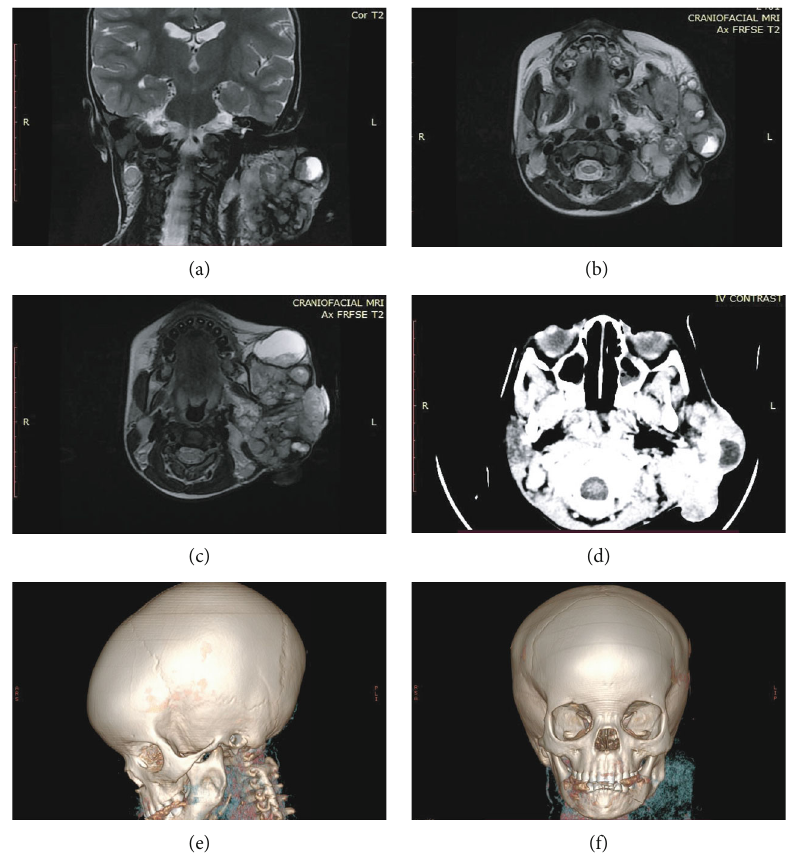
Figure 2: Radiologic imaging of a female child diagnosed with a MAML2 -rearranged mucoepidermoid carcinoma of the parotid gland. MRI T2-weighted coronal and axial views (a) – (c) CT scan axial view (d), and 3D-refomatted CT scans (e, f) showing a soft tissue swelling over the left jaw region with no bony lytic or sclerotic lesion. The bony outline was preserved, with a cupping e ff ect on the ramus of the